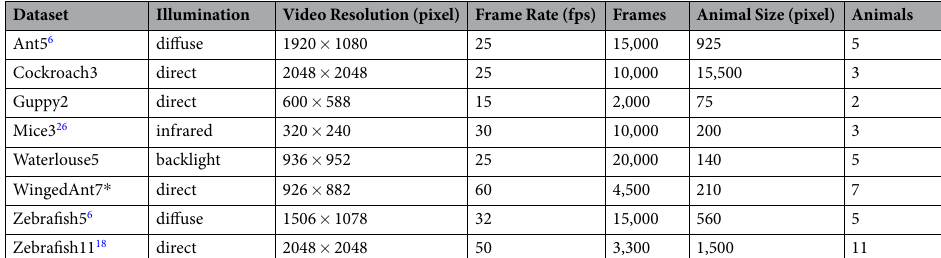
Table 1. Dataset details. ( * ) dataset provided by the department of evolutionary biology and environmental studies from the University of Zurich. The original video can be downloaded at http://www.roborealm.com/